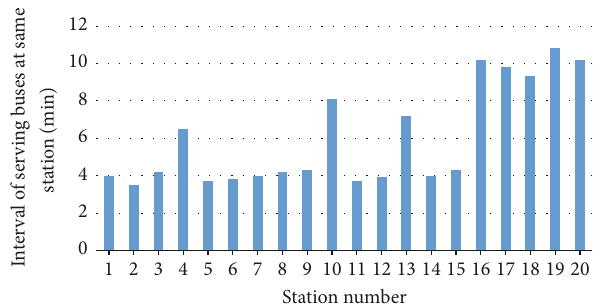
Figure 8: Interval of serving buses at the same station.